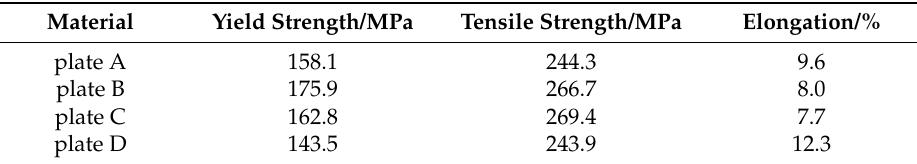
Table 4. Summary of tensile properties of plates A, B, C, and D.